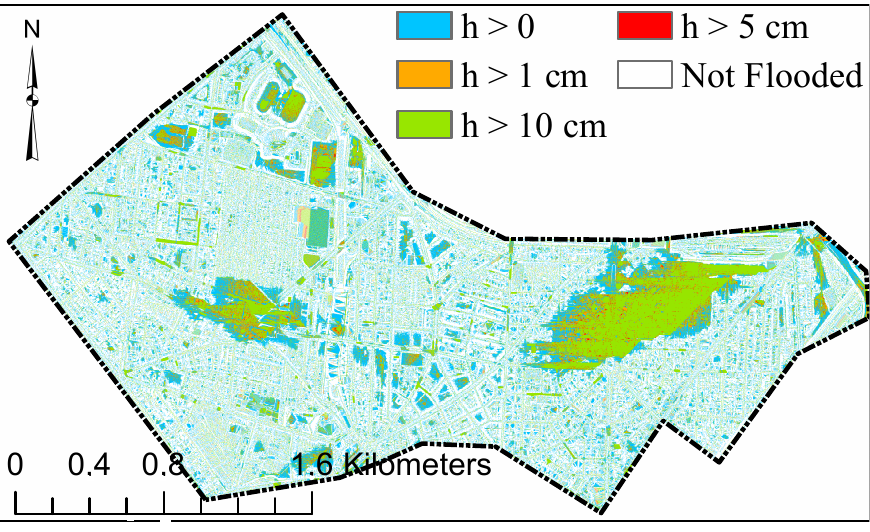
Figure 10. Flood-prone area (FP) for different water depth thresholds for a 100 mm precipitation